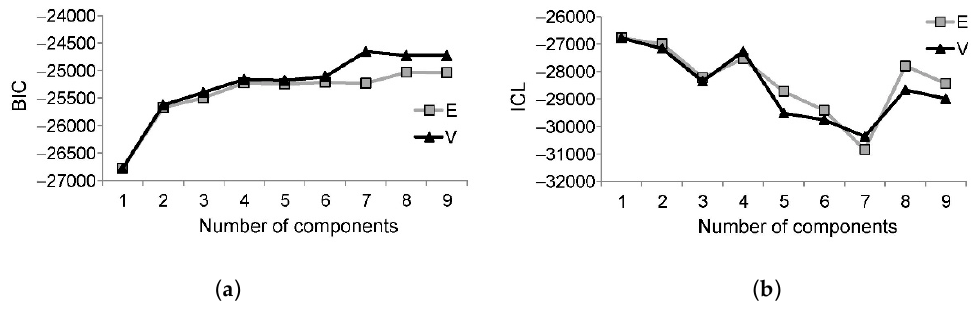
Figure 4. Bayesian information criterion (BICs) and integrated complete-data likelihood criterion (ICLs) for the Gaussian mixture models built for head capsule widths of Dendrolimus pini with various numbers of components (instars): ( a ) BIC and ( b ) ICL; E—Models for equal variances, V—Models for unequal variances.